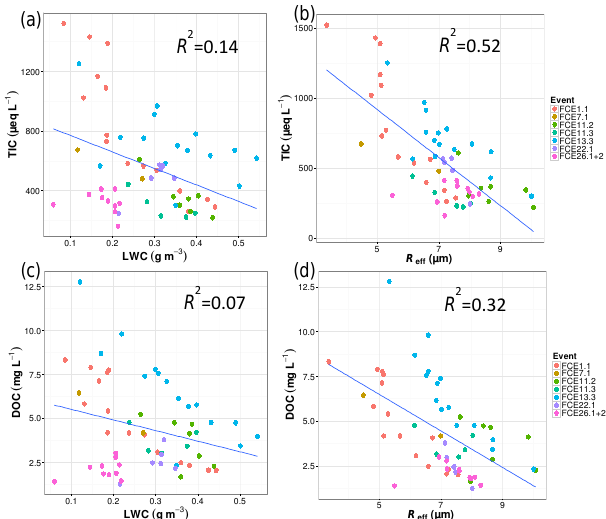
Figure 4. Relationships of total ionic content (upper panels) and dissolved organic carbon (lower panels) versus liquid water content (a, c) and effective droplet radius (b, d) for bulk cloud water sam- ples.